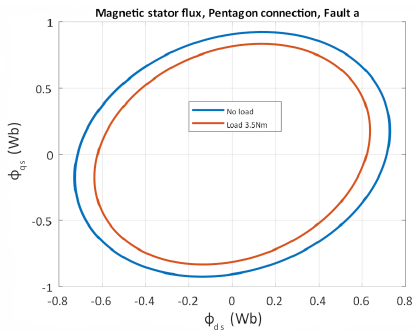
Figure 21. Magnetic stator flux, star connection, fault phase a.